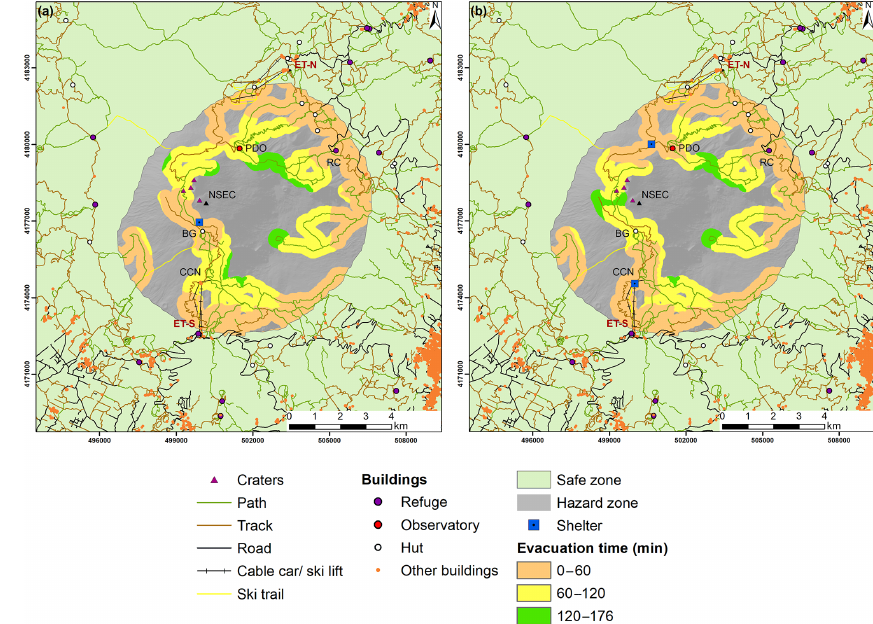
Figure 5. Evacuation times to reach the safe zone (for ERS) based on walking speed of 3.3kmh − 1 , assuming people start a maximum of 300m from any path, with (a) one shelter and (b) two shelters. The hazard zone is the area with a probability of impact from 5cm clast ≥ 1%. The safe zone includes areas with a probability of impact < 1%. NSEC: New Southeast Crater. Ski areas: ET-N: Etna Nord; ET-S: Etna Sud. BG: Baita delle Guide; CCN: top station of the Funivia dell’Etna cable car; PDO: Pizzi Deneri Observatory; RC: Rifugio